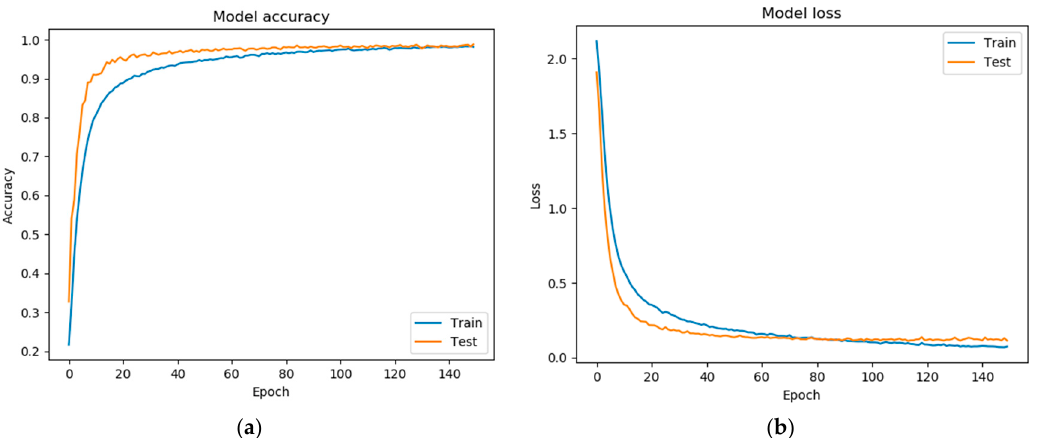
Figure A2. Model accuracy and loss for CNN network: ( a ) accuracy over 100 iterations, ( b ) loss over 100 iterations.